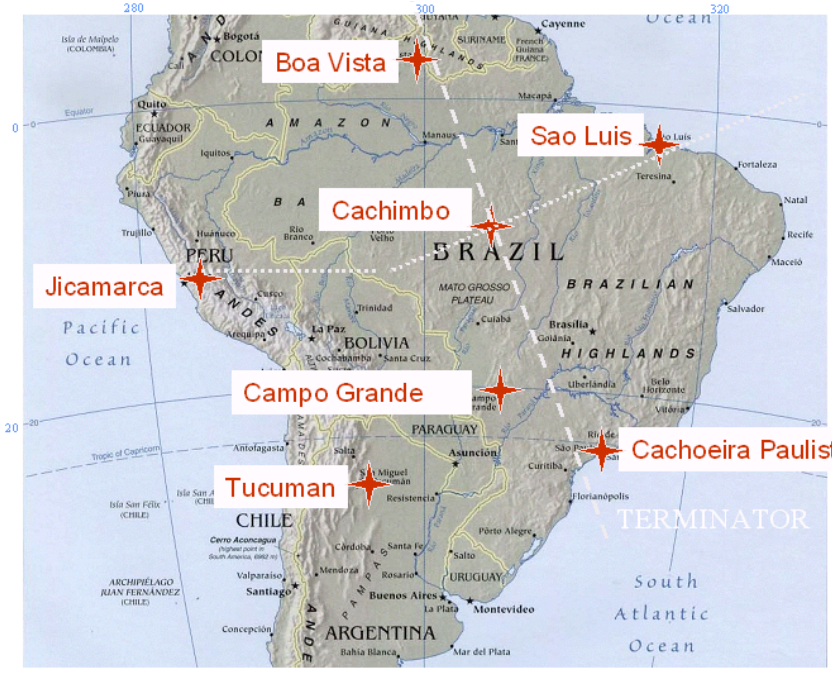
Fig. 1. Location of the seven digisondes in South America. Figure 1. Location of the seven digisondes in South America